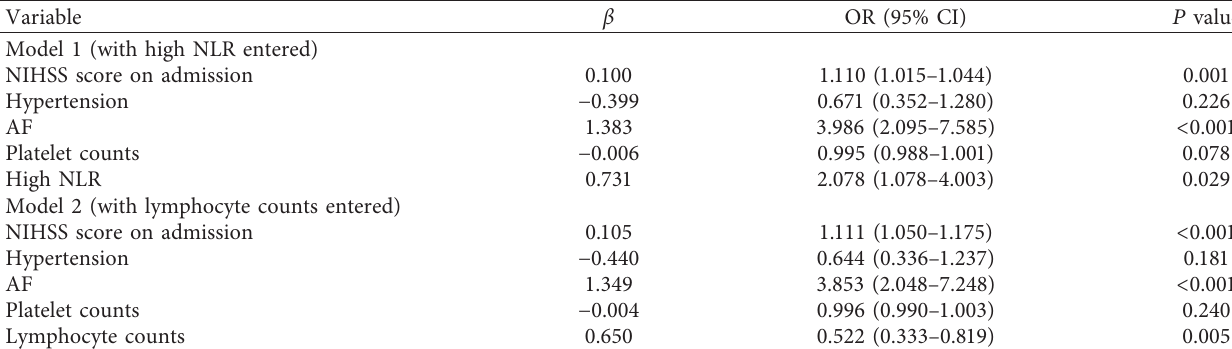
Table 3: Multivariate logistic regression of risk factors for hemorrhagic